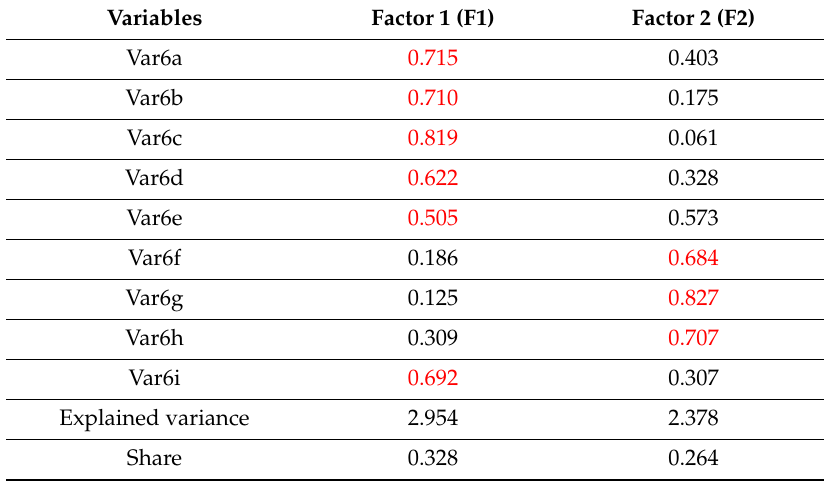
Table 6. Factor loads after the Varimax rotation, normalized with the isolation